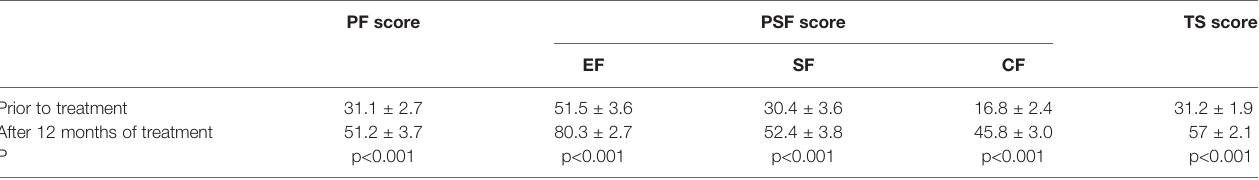
TABLE 2 | Results of the quality of life evaluation using PedsQL 4,0.